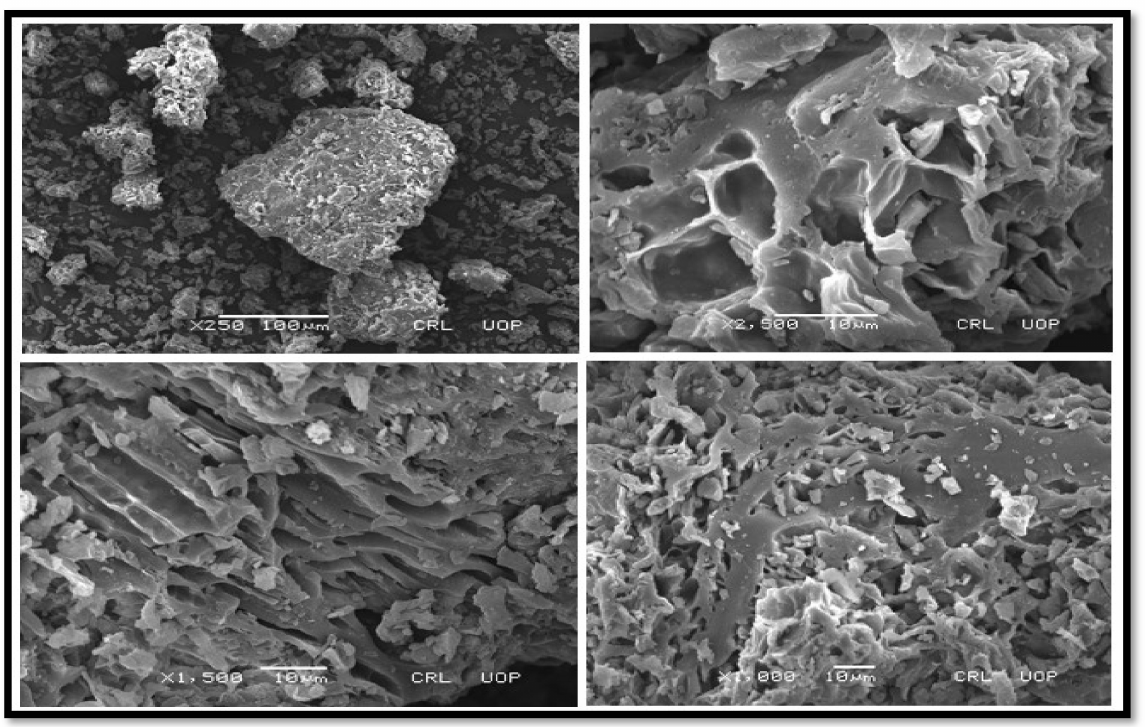
Figure 6. SEM images of CPC with changed